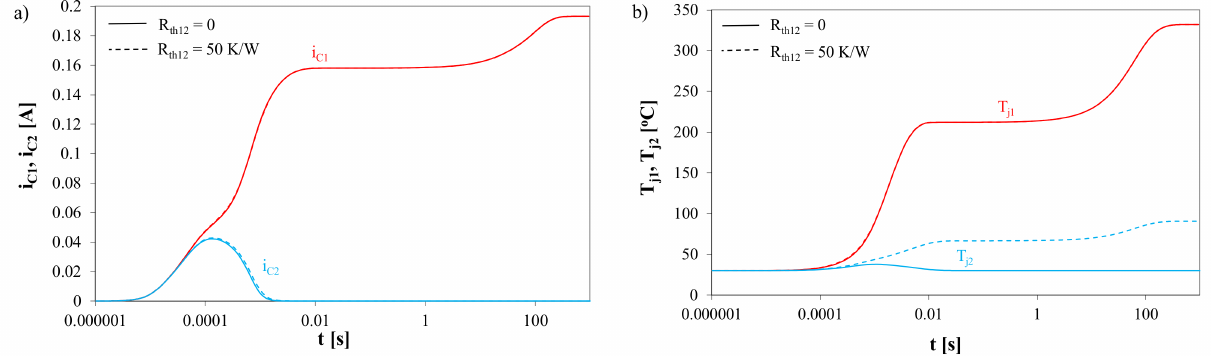
Figure 14. Collector currents ( a ) and junction temperatures ( b ) of BJTs having different values of the shortest thermal time constants: for transistors T 1 and T 2 equal to 2 ms and 5 ms, respectively at R th 12 = 0 (solid lines) and at R th 12 = 50 K/W (dashed lines).